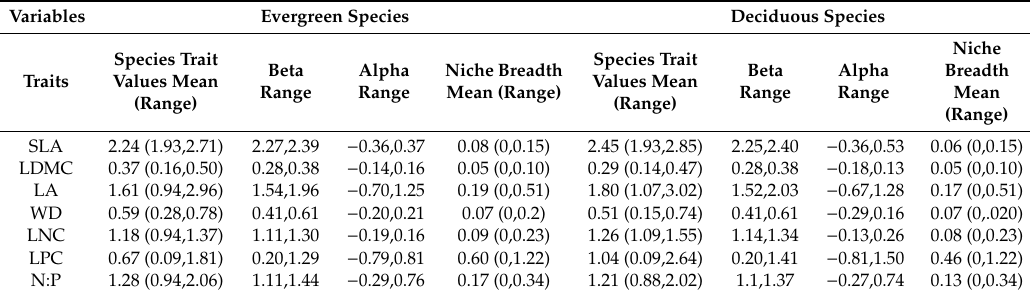
Table 1. Summary statistics for the seven traits measured across 170 evergreen and deciduous species in Central China. All results and measurements of the various components of TGA are shown in back-log10 transformed (actual) trait